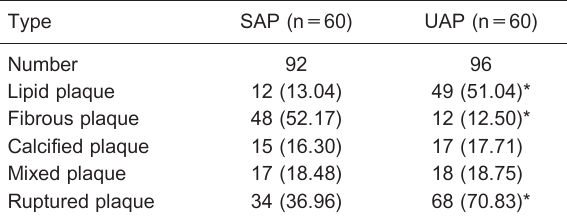
Table 1. Plaque type of the lesions in the stable (SAP) and unstable (UAP) angina pectoris groups of